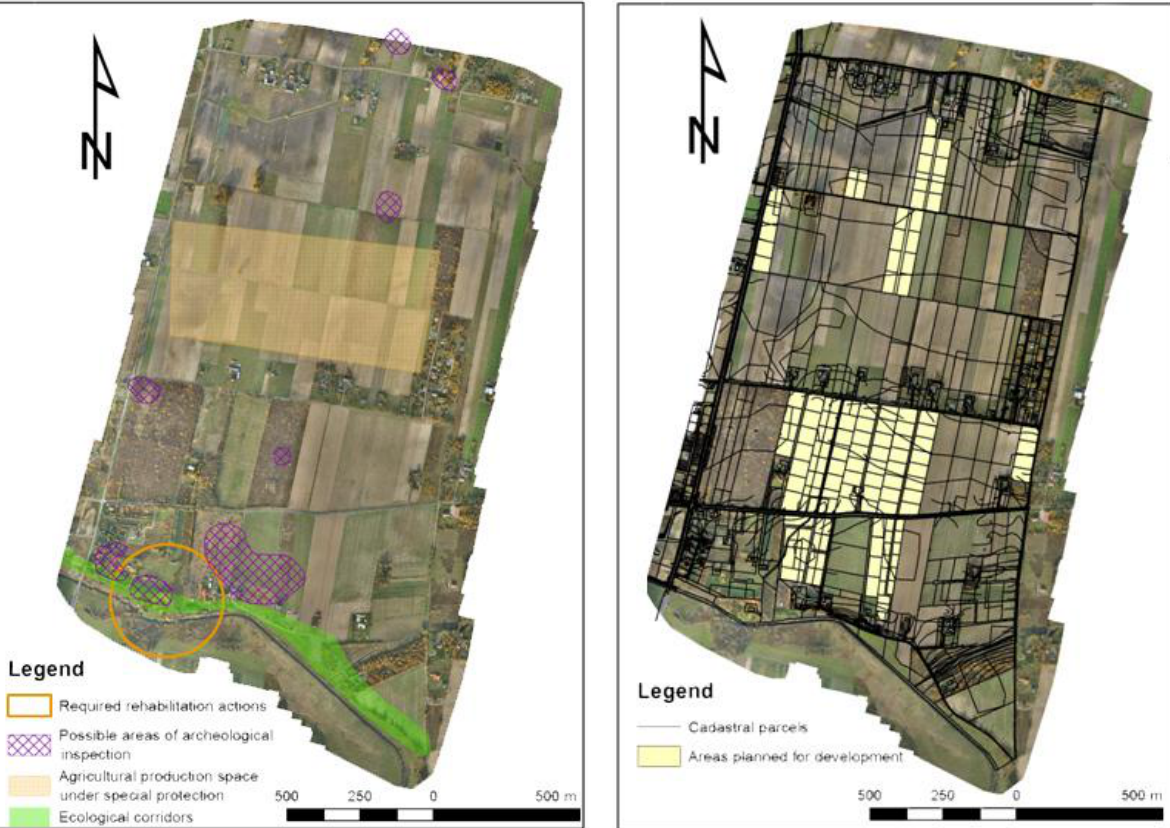
Fig. 4. Identification of areas of high natural value: Figure.5. Parcels earmarked for future